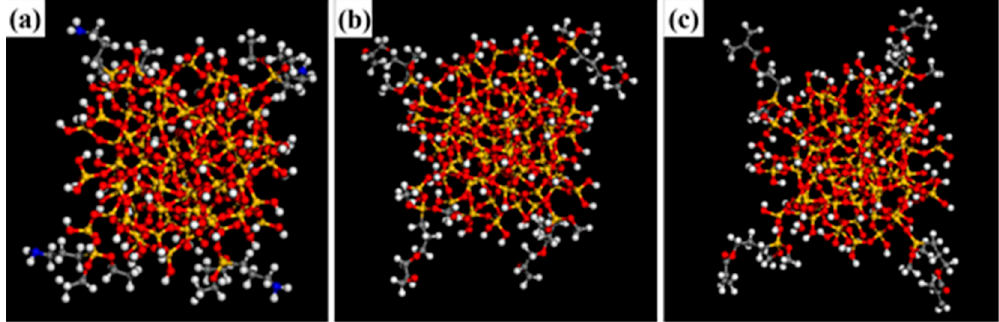
Figure 3. Model of modified-SiO 2 : ( a ). KH550-SiO 2 , ( b ). KH560- SiO 2 , ( c ). KH570-SiO 2 .